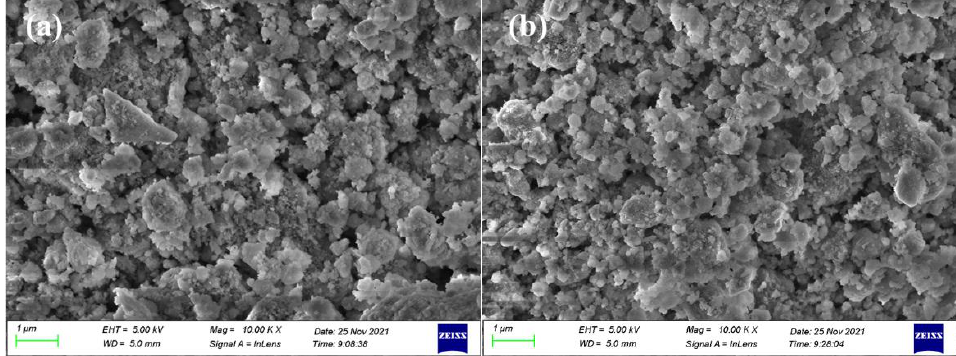
Figure 4. 10 K magnification SEM images of (a) raw red mud; ( b ) red mud after ball milling.